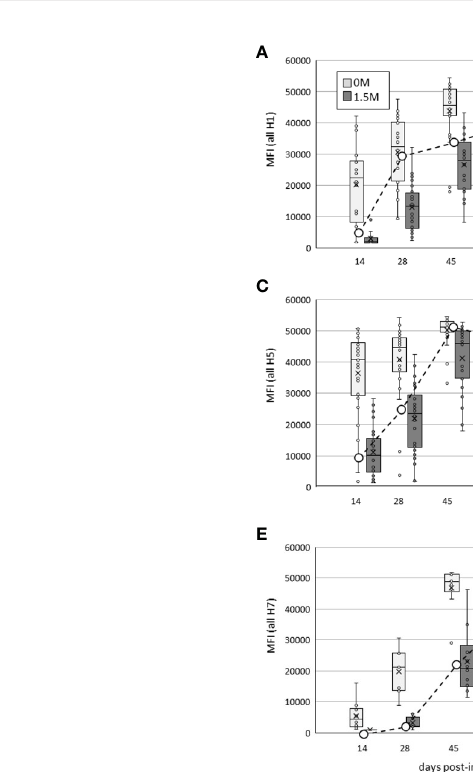
FIGURE 8 | Administration of H1+H5+H7 multivalent cocktail engenders increases in antibody avidity to individual components over time. Mice were administered a single dose of trivalent cocktail in IVAX-1 adjuvant, and plasma samples collected at days 14, 28, 45, 73 and 86 post-immunization. Shown are array signal intensities for variants of the immunizing subtypes: (A, B) , H1 antigens; (C, D) , H5 antigens; (E, F) , H7 antigens. (A, C, E) show HA protein array signal intensities with or without 1.5M NaSCN (dark grey and light grey boxes, respectively); each panel is overlaid with avidity indexes of antibodies to the immunizing antigen (secondary axis, hashed line); (B, D, F) show corresponding avidity indexes to all H1, H5 and H7 variants, respectively, on the